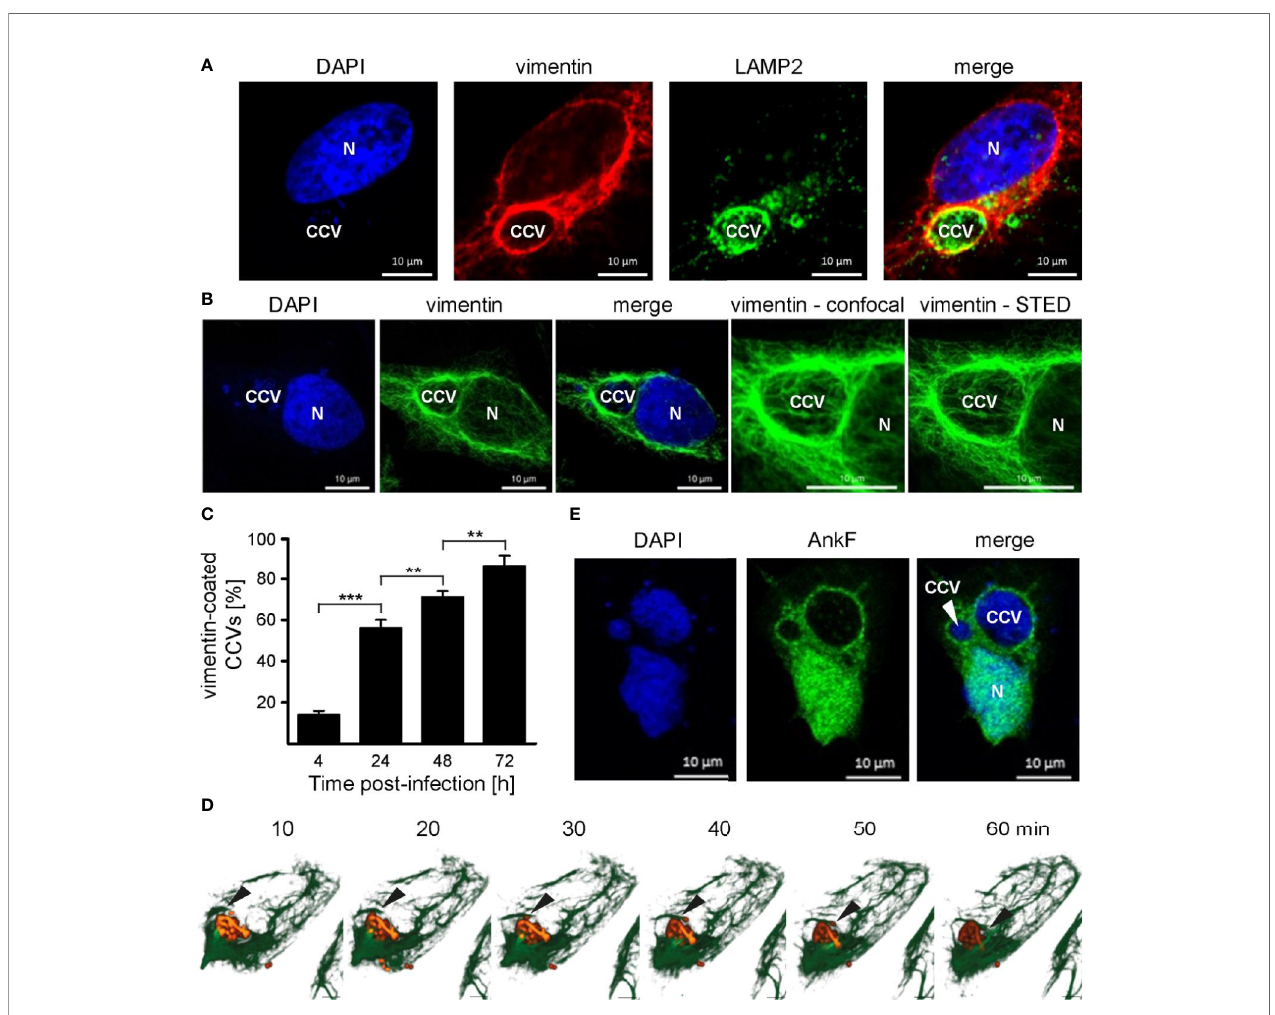
FIGURE 8 | Vimentin and AnkF associate with the CCV. (A) HeLa cells were infected with C. burnetii at an MOI of 50 for 24 h. Cells were fi xed and stained with vimentin- and LAMP2-speci fi c antibodies by indirect immuno fl uorescence (red and green, respectively). Nuclei and bacterial DNA were stained with DAPI (blue). Cells were visualized using LSM. (B) Infected cells were fi xed and stained with a vimentin-speci fi c antibody by indirect immuno fl uorescence (green). Nuclei and bacterial DNA were stained with DAPI (blue). Cells were visualized using LSM or Stimulated Emission Depletion (STED) high-resolution laser scanning fl uorescence microscopy to highlight the close association of vimentin with the CCV. (C) HeLa cells were infected with C. burnetii at an MOI of 50 for up to 72 h. At the time points indicated, cells were fi xed and vimentin and C. burnetii were stained with speci fi c antibodies by indirect immuno fl uorescence. Using LSM, 100 cells were counted per each of three independent experiments for association of vimentin with the CCV. Error bars indicated ± SD. ** p < 0.01, *** p < 0.001. (D) Stable U2-OS-rseGFP-vimentin cells were infected with recombinant, inducible td-Tomato-expressing C. burnetii in the presence of 2 mM IPTG at an MOI of 100. At 72 h post infection, live-cell imaging was performed using Spinning Disc Confocal Microscopy. Z-stack images were acquired in a 15- m m range in 0.2- m m intervals every 10 min during a time period of 1 h. 3D re-construction was performed using ZEN software (Carl Zeiss AG) to visualize rseGFP-vimentin (green) and C. burnetii -tdTcc (red). Black arrows indicate the growing tip of vimentin fi laments on the CCV. Scale bar: 5 m m. (E) HeLa cells were infected with C. burnetii at an MOI of 50. After 6 days, cells were transfected with pcDNA-AnkF. 24 h post-transfection, the cells were fi xed and stained with an anti-AnkF-serum (green). Nuclei and bacterial DNA were stained with DAPI (blue). A representative LSM image from three independent experiments is